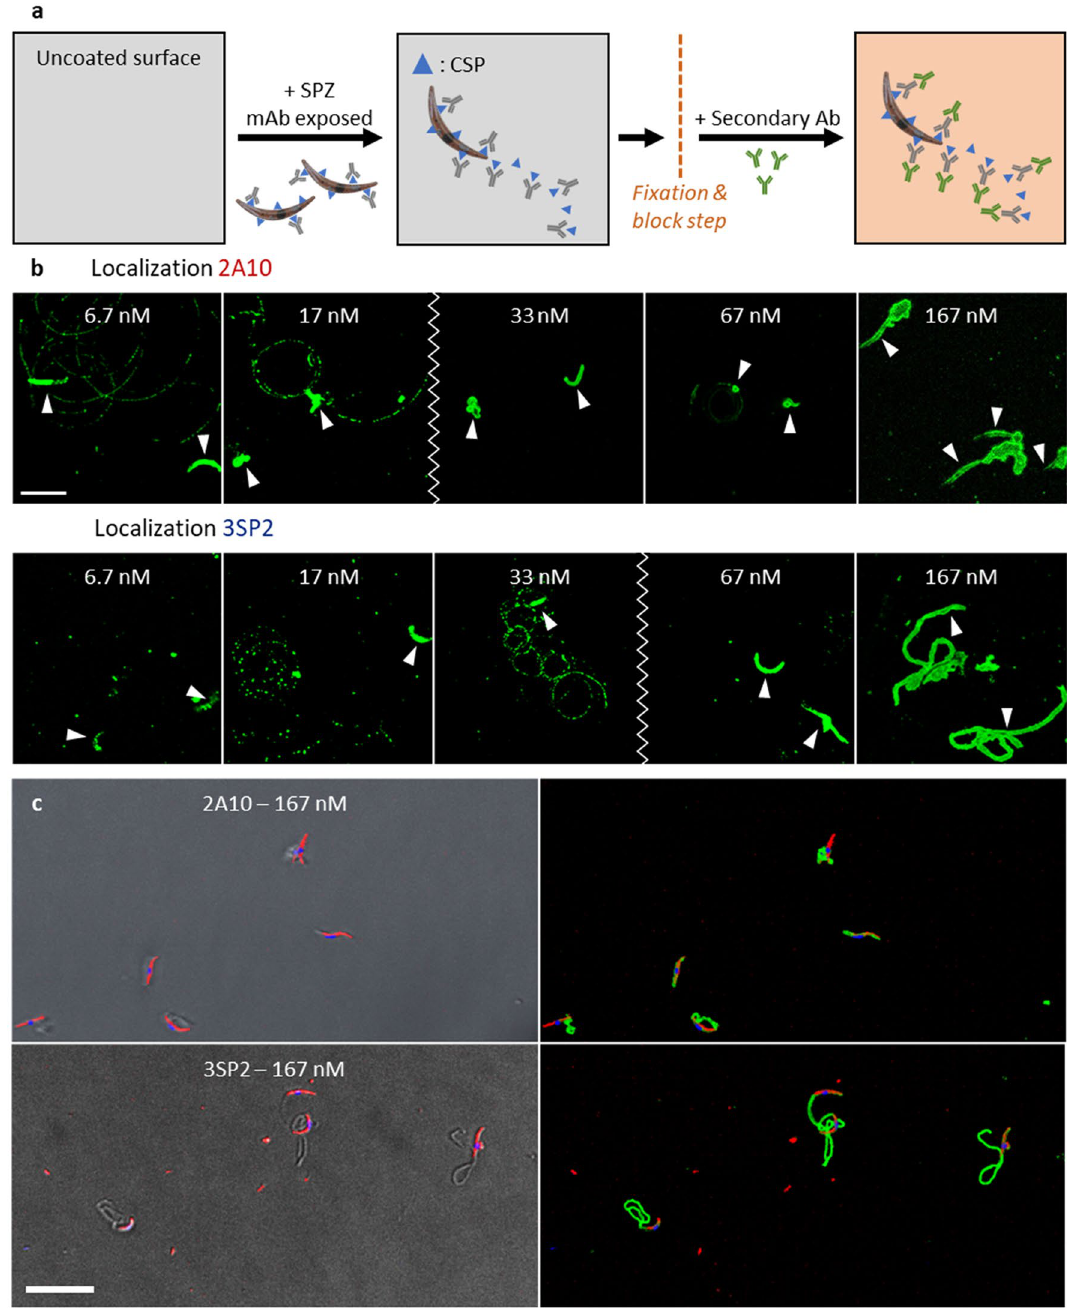
Figure 3. Localization of anti-CSP mAb ( a ) Schematic overview of the localization of bound anti-CSP mAbs using a fluorescent secondary Ab. ( b ) Visualization of the presence of the anti-CSP mAbs 2A10 and 3SP2; the mAbs staining is shown in green, the location of the SPZ is depicted with an arrow and the zigzag line indicates at which concentration the mAbs started to induce protrusions. Scalebar: 10 μm. ( c ) Visualization of the presence and the effect of 2A10 and 3PS2 on SPZ; to the left an overlay of the brightfield image with the SPZ counterstained with Cy5-Methyl-Methyl (shown in red) and Hoechst (shown in blue) and to the right an overlay of the mAbs staining (shown in green) and the counterstained SPZ. Scalebar: 20 tions of 333 nM for 30 min did not block SPZ motility as compared to untreated controls (median velocity of 1.8 (IQR: 1.1–2.4) μm/s (Fig. 4b,c)). Only at high concentrations (≥ 67 nM for 2A10 and 333 nM for 3SP2) the SPZ velocity significantly decreased to respectively 1.0 (IQR: 0.6–1.5) and 1.4 (IQR: 0.8–2.0) μm/s ( p < 0.001 and p = 0.002, Mann–Whitney U test) (Fig. 4b,c). Increasing concentrations of 2A10 did not further reduce SPZ velocity (median velocity SPZ exposed to 333 nM 1.0 (IQR: 0.7–1.3) μm/s; p = 0.829 when compared to 67 nM, Mann–Whitney U test) which corresponded with the abovementioned finding that a subset of SPZ is less sus-